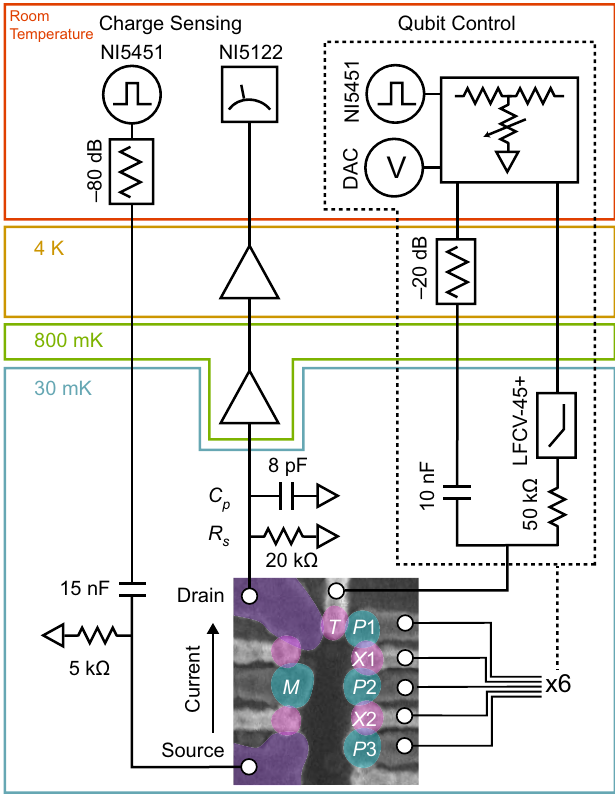
FIG. 1. The signal chain. Square waves are generated at room temperature, attenuated, and sent into the dilution refrigera- tor, where they act as a bias between source and drain two- dimensional-electron-gas (2DEG) leads. These square waves probe the conductance of the DCS (labeled “M”), which is sen- sitive to the TQD charge state, and generate a current across a subsequent 20-k (cid:2) sense resistor. This signal is amplified by a two-stage cryogenic HEMT, then demodulated and thresh- olded at room temperature. Signal-adder circuits (dashed con- tour) enable fast and accurate baseband control of the plunger (blue, “P” and “M”) and barrier (pink, “T” and “X”) gate biases. The adder circuit (simplified in this figure) is described in further detail in Appendix A. Note that the source-signal attenuation has a low-impedance